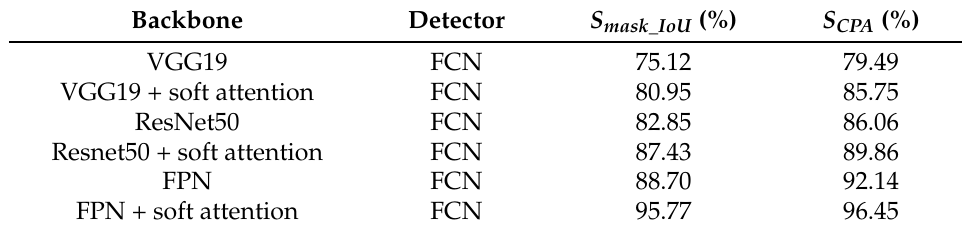
Table 3. Comparison of oil spill detection models S mask _ IoU and S CPA .